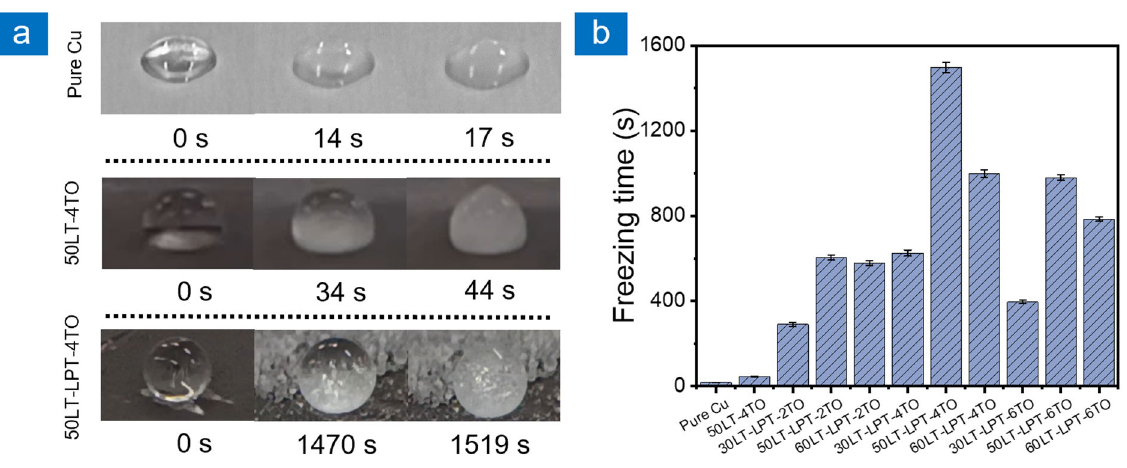
Figure 4. Anti ‐ icing performances of different samples at a surface temperature of − 10 °C. ( a ) Freezing process of a single droplet on different samples. ( b ) Delayed freezing time of different samples.